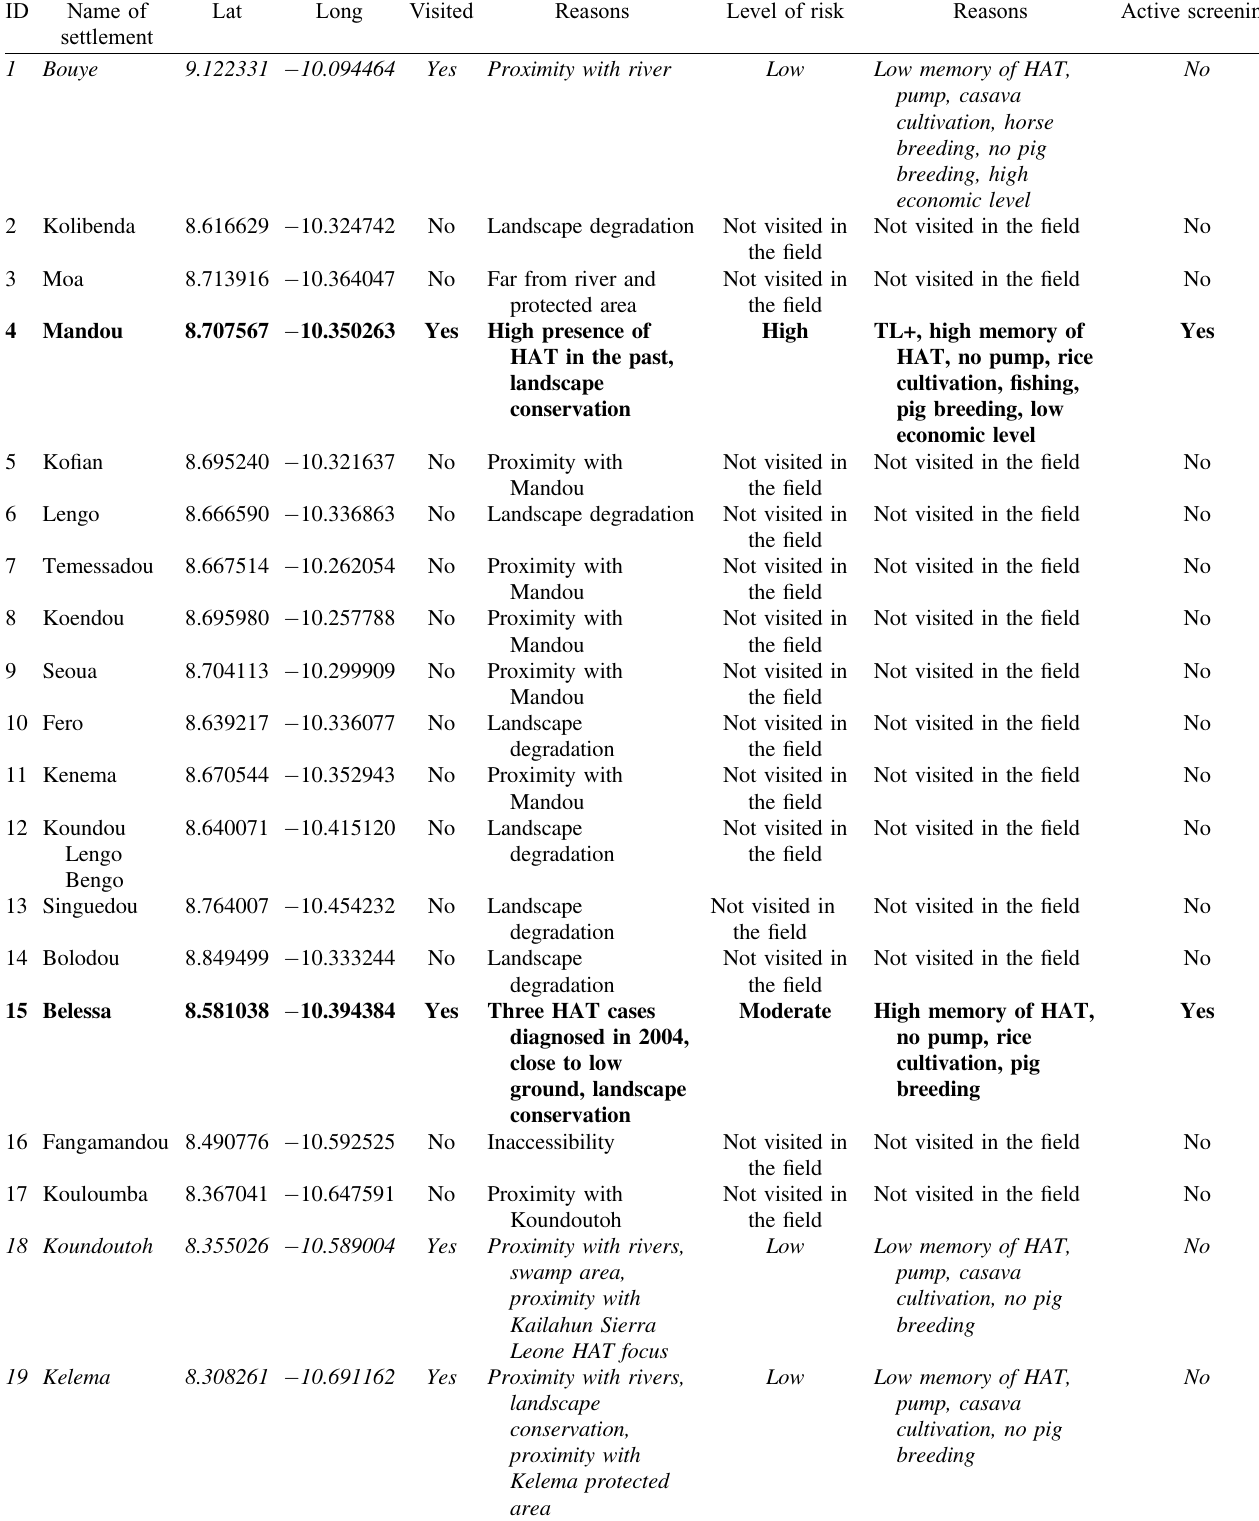
Table 1. Names and geographical coordinates of the 49 villages identi fi ed as at risk of